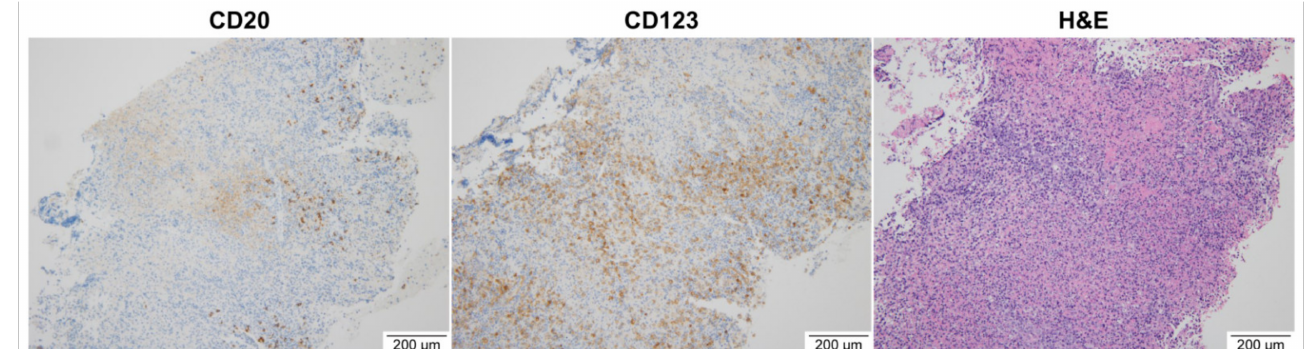
Figure 3. Pathologic findings of the axillary lymph node through a core needle biopsy. CD20 (a marker of B cells) is negative, and CD123 (a marker of basophils and dendritic cells) is positive. It shows extensive necrosis and atypical lymphoid hyperplasia on H&E stain.